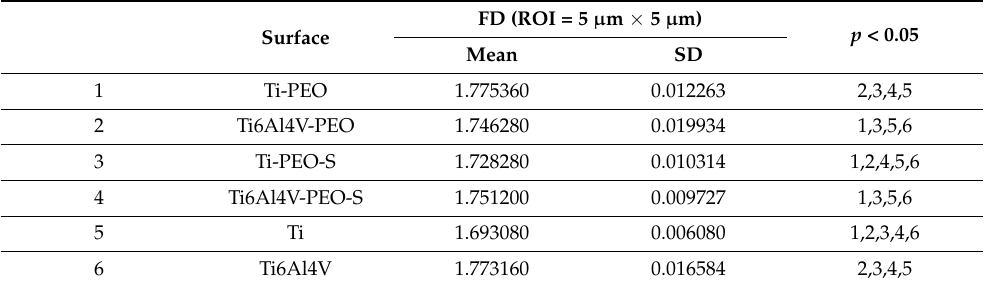
Table 4. Post hoc ANOVA results (least significant difference) for comparison of fractal dimension for ROI size 5 µ m × µ m between each examined surface.